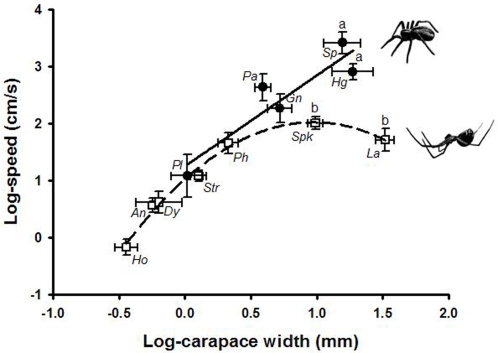
The relationship between running performance on the ground and body mass across spider taxa.Filled circles and solid line: standing spiders; Open squares and dashed line: hanging spiders. Means were obtained across different instars for each spider group. Errors are s.e.m. The fitted model for standing spiders is: (log_speed = 1.3+1.6*log_carapace_width, P = 0.025). The fitted model for hanging spiders is: (log_speed = 1.3+2.1*log_carapace_width–1.1*log_carapace_width2, both regression coefficients P<0.001). Letters on top of bars indicate significant differences between groups according to a Bonferroni-corrected post-hoc Kruskal-Wallis ANOVA test (P<0.05). The letters in italic denote the spider taxa used: An, Anelosimus; Dy, Dyctinidae; Gn, Gnaphosidae; Hg, Hogna; Ho, Holocnemus; La, Latrodectus; Pa, Pardosa; Ph, Pholcus; Pl, Philodromidae; Sp, Sparassidae; Spk, Steatoda paykulliana; Str, Steatoda triangulosa (see Table S2 for further details).